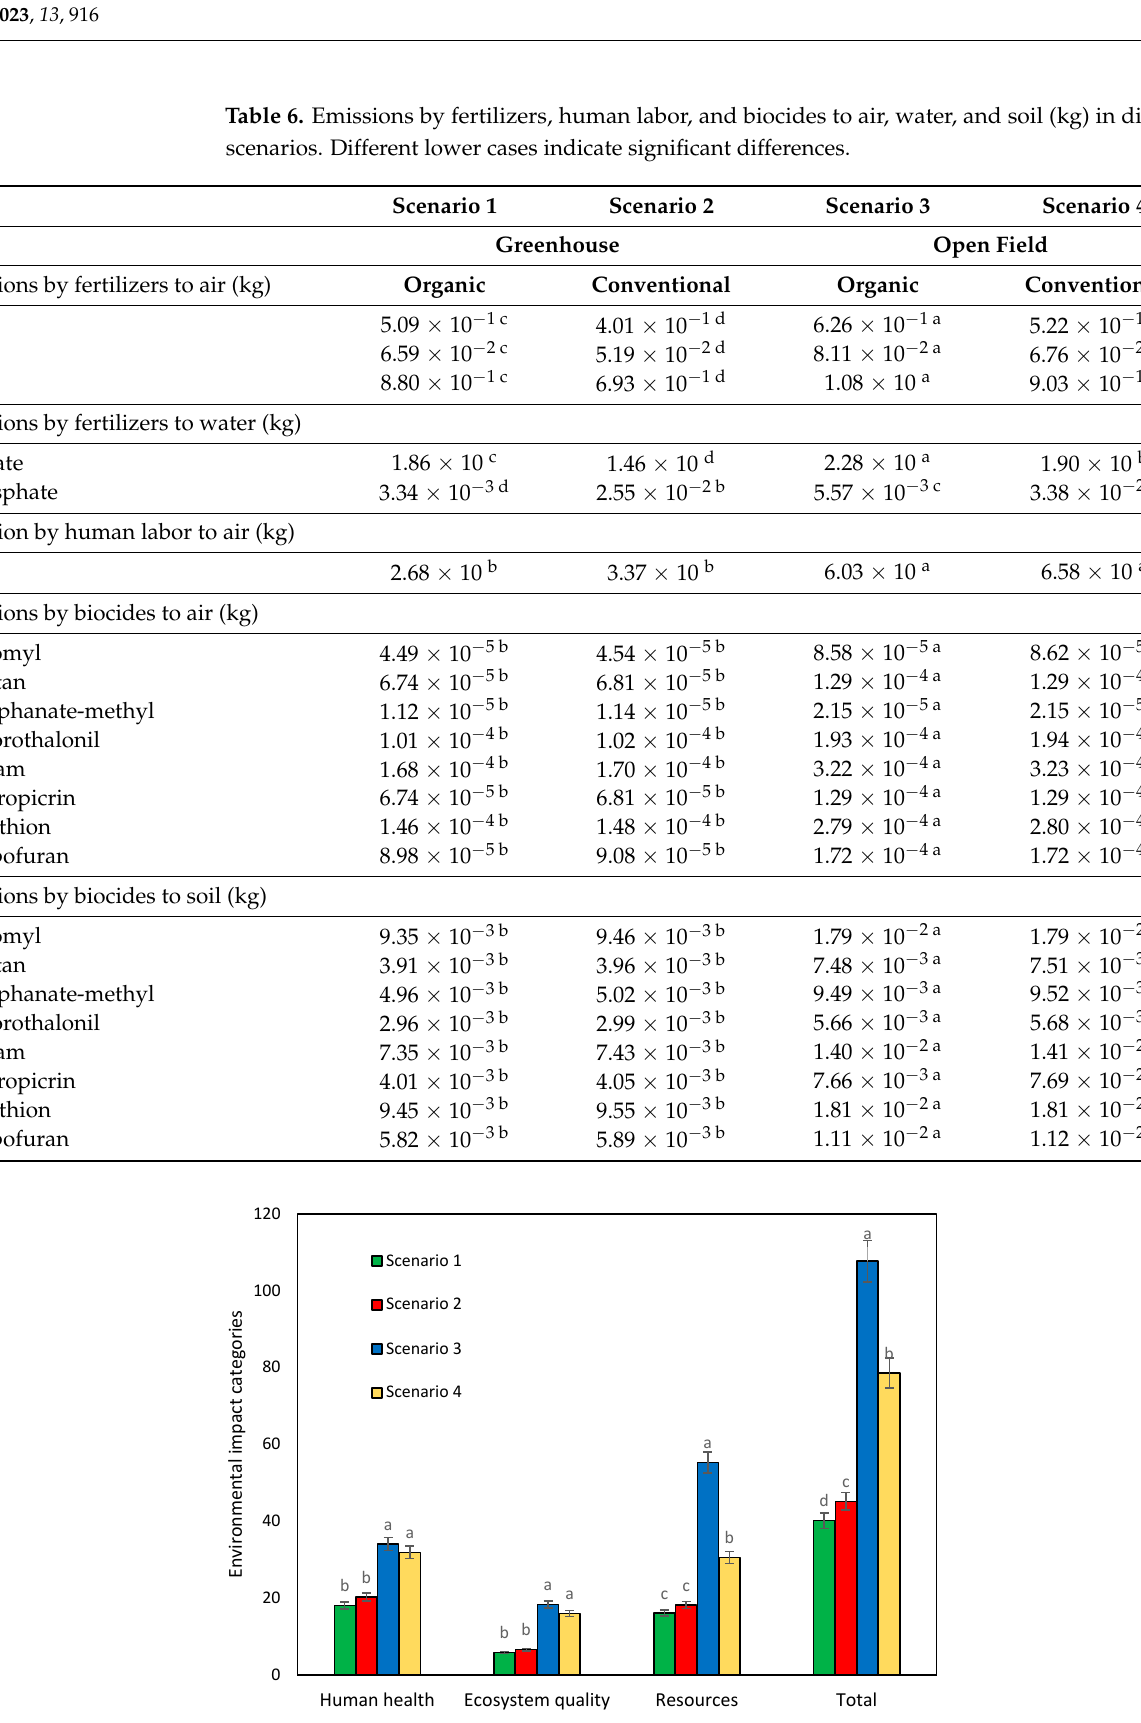
Figure 3. Comparison between damage assessment of tomato production in different scenarios (Sce ‐ nario 1: Greenhouse—Organic, Scenario 2: Greenhouse—Conventional, Scenario 3: Open Field— Organic, Scenario 4: Open Field—Conventional). In this figure, the comparison of different scenar ‐ ios has been done for each environmental impact category (human health, ecosystem quality, re ‐ sources, and total). Different lower cases indicate significant differences.